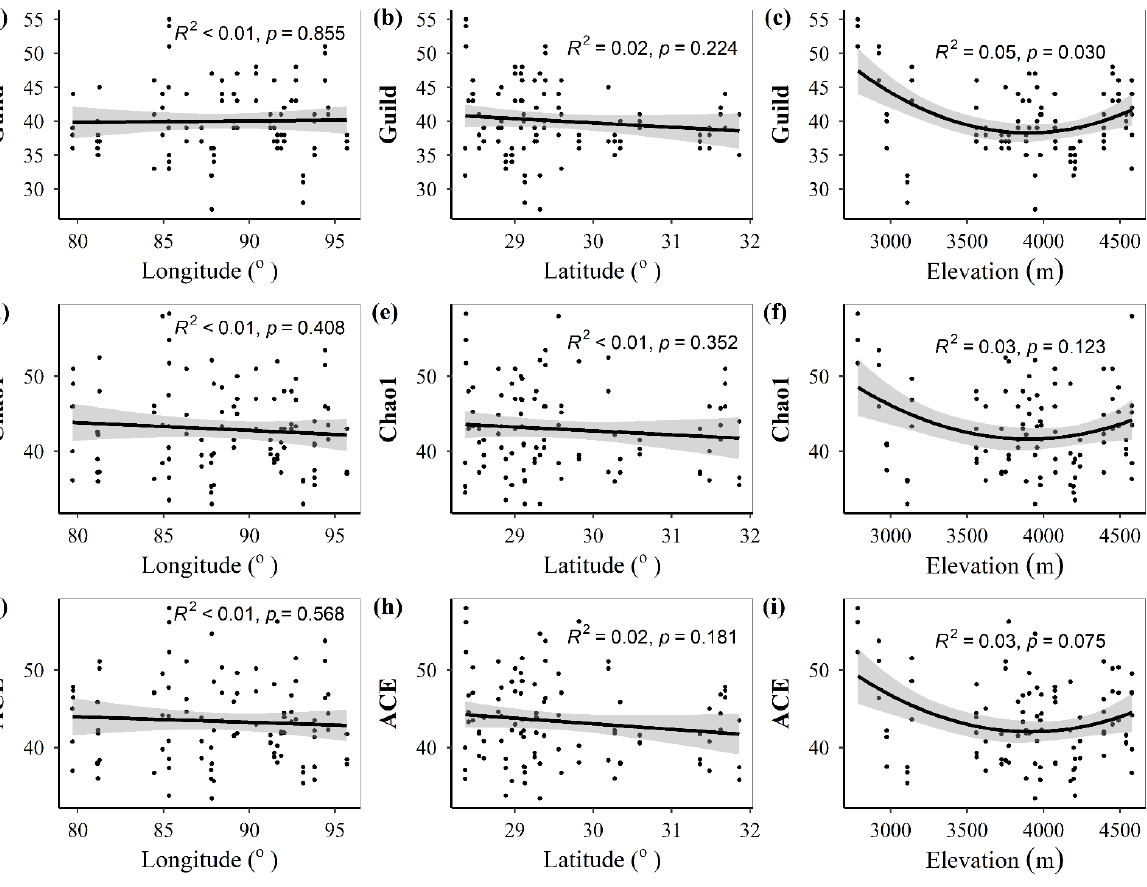
Figure A16. Cont